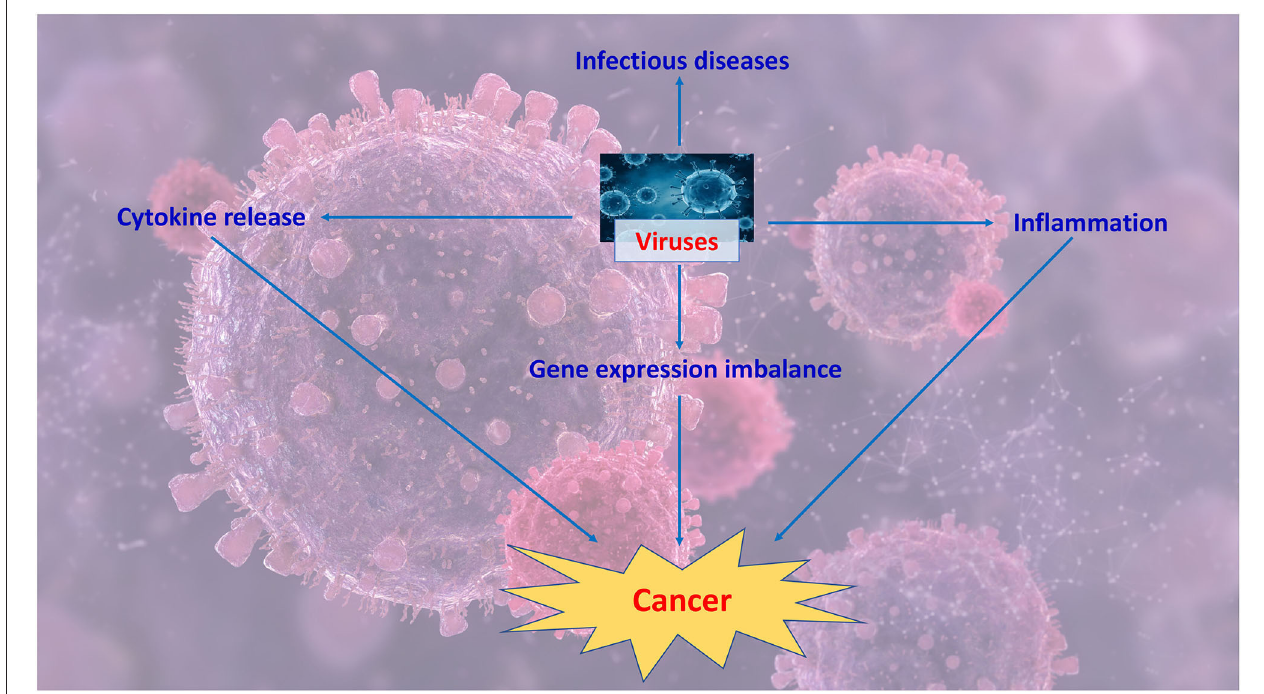
FIGURE 1 | Viruses might contribute to cancer by inducing a prolonged inflammation, dysregulating immune response and unbalancing gene